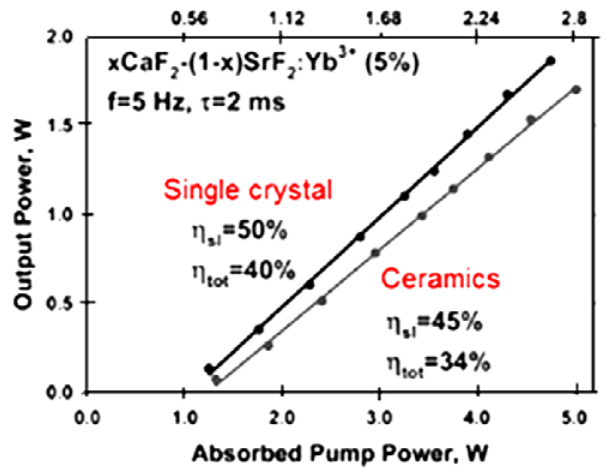
Figure 11. Lasing results for 5%-Yb 3+ :0.65CaF crystal (Adapted from